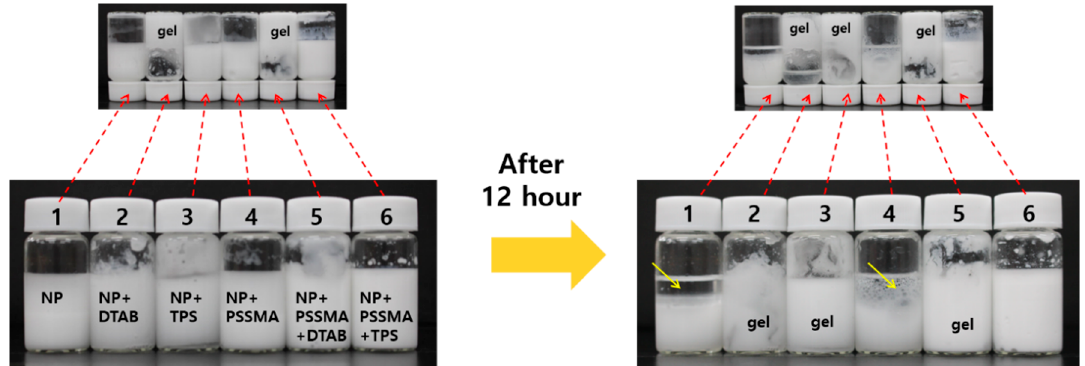
Figure 3. Emulsion stabilities of various colloidal dispersions. In samples 1 and 4, a yellow arrow indicates the oil due to phase separation.